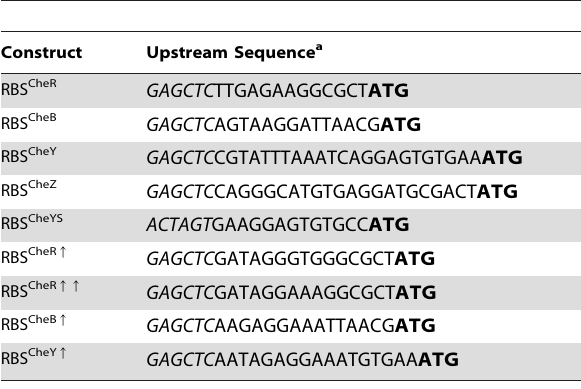
Table 4. Upstream ribosome binding sequences of the fusion